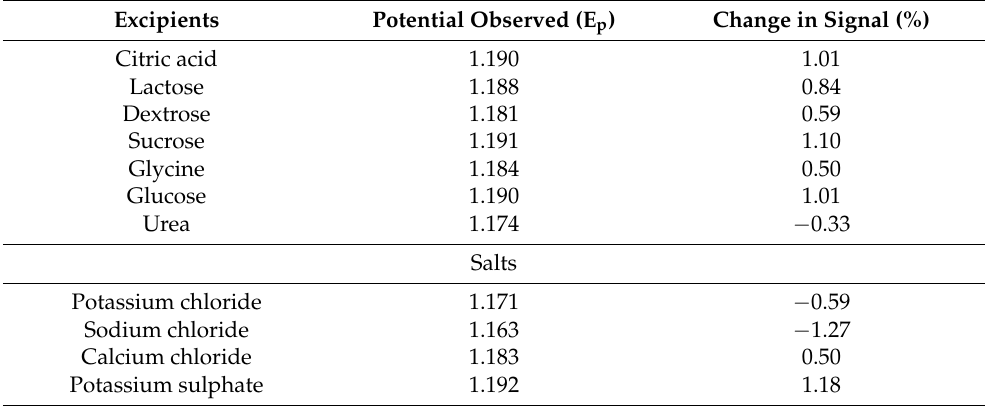
Table 4. Excipient study of TMP.